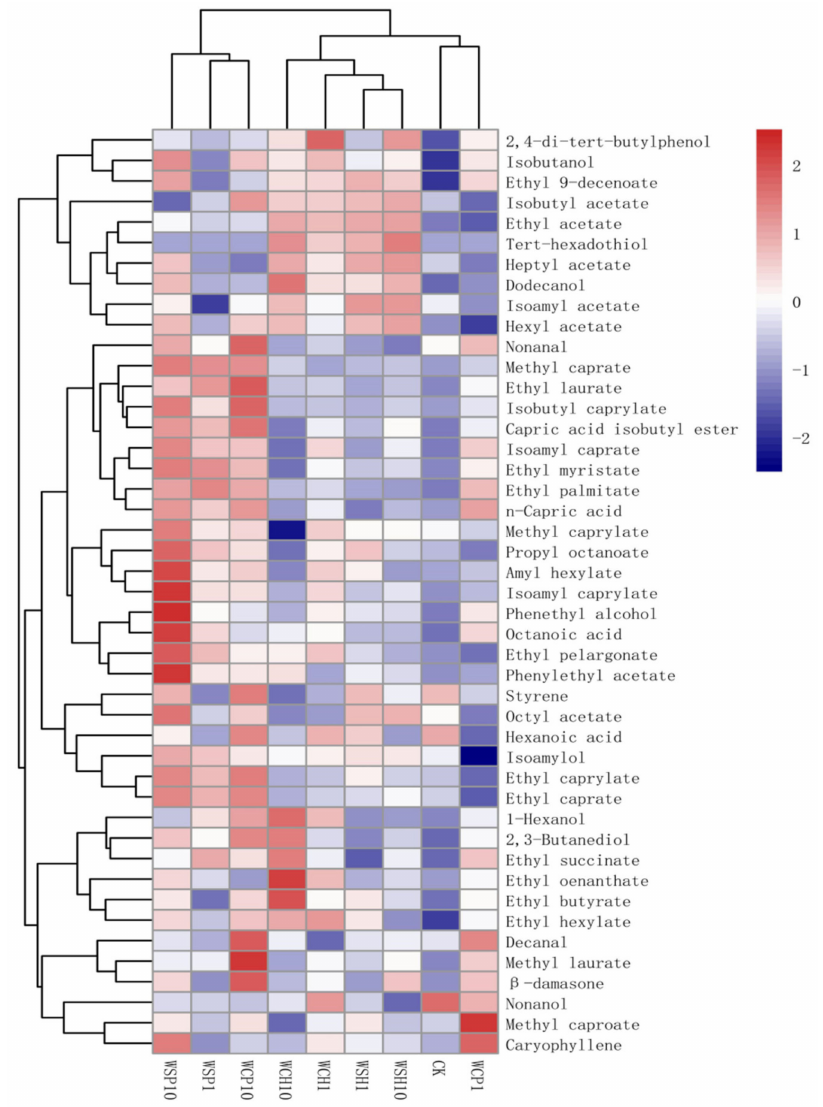
Figure 3. Cluster heat map analysis of aroma components of wine